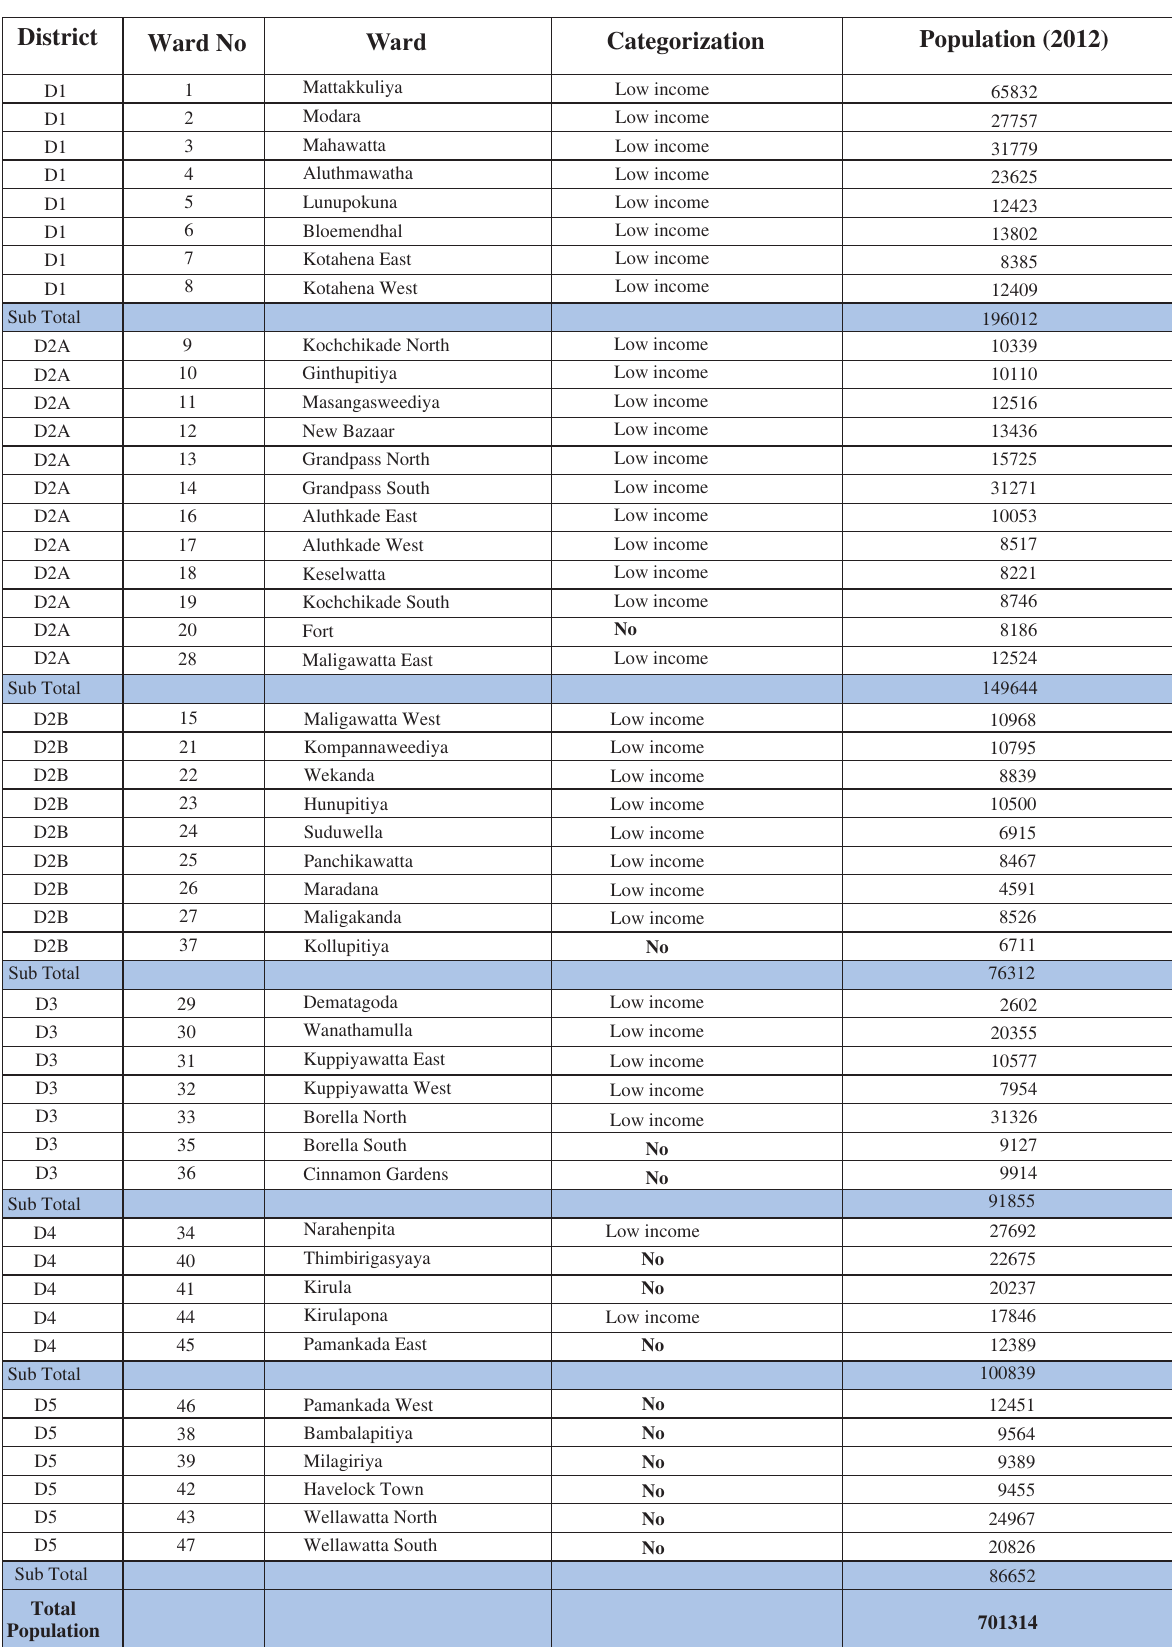
Table 1: Population characteristics of the Colombo Municipal Council Wards District Ward